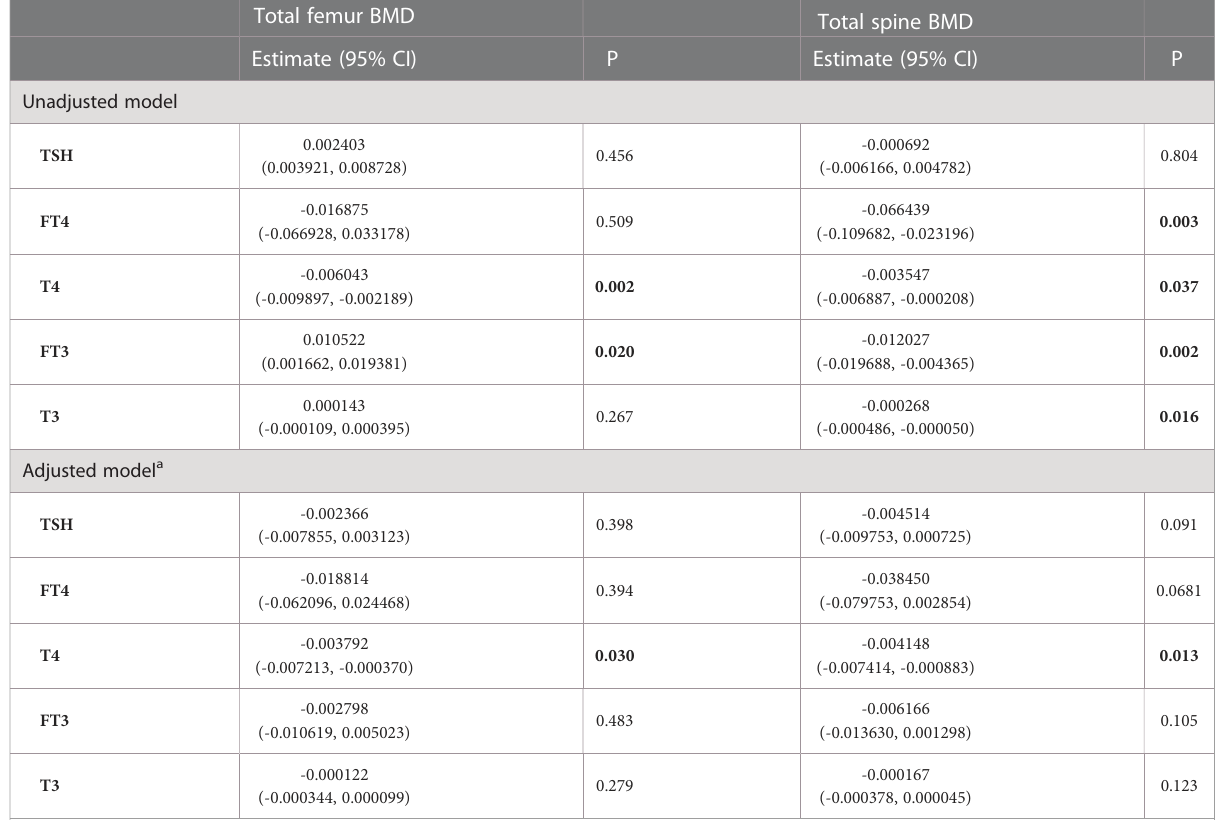
TABLE 5 Association of the thyroid hormone pro fi le with BMD in participants aged 20 – 50